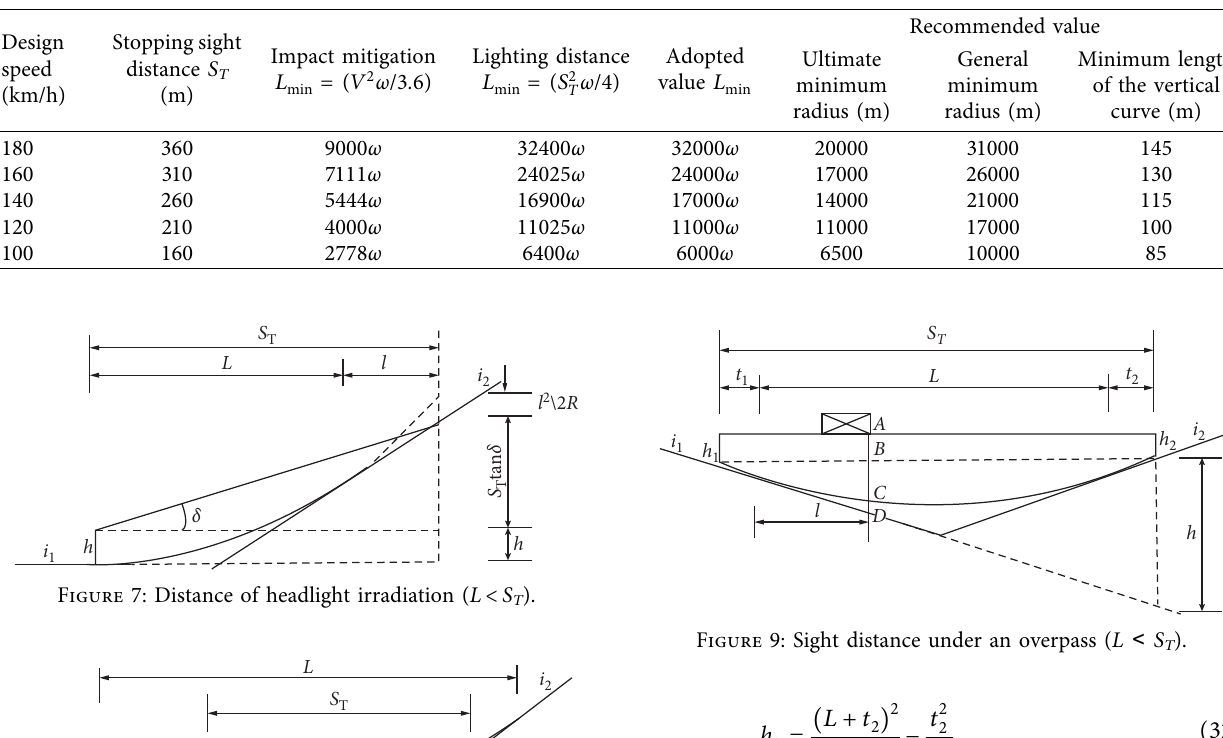
Table 13: The minimum radius and length of a convex vertical curve of a superhighway.